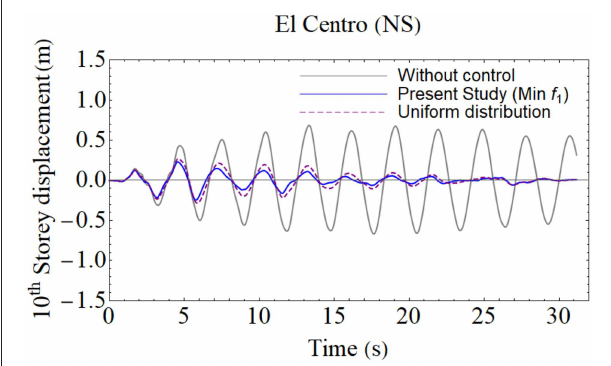
FIGURE 10 | Time history of 10 t h story displacement of the shear